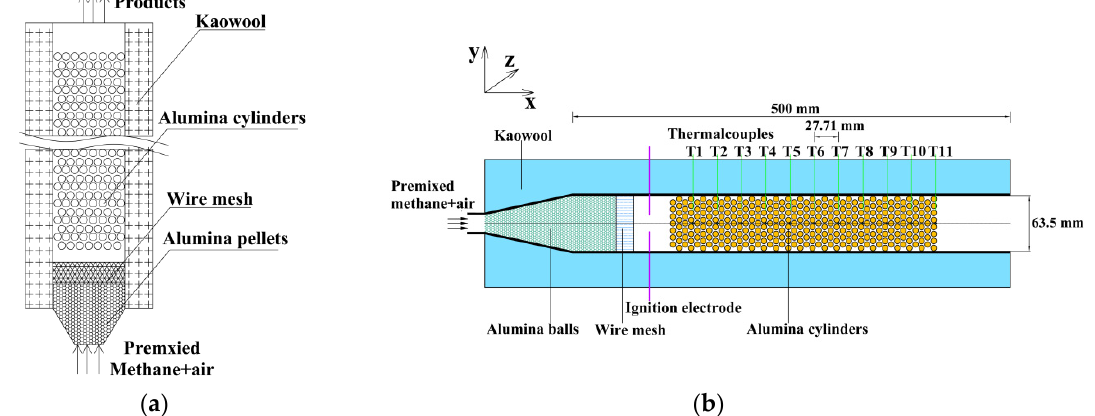
Figure 2. The setup of the burner. ( a ) The schematic diagram of the burner; ( b ) The arrangement of the alumina cylinder.